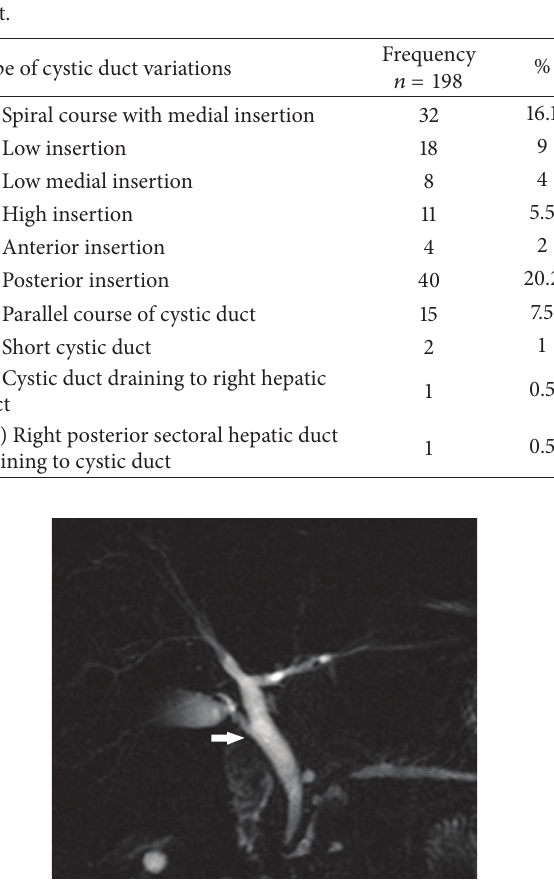
Figure 1: Coronal oblique 3D MR cholangiopancreatography shows normal insertion of cystic duct at middle 3rd of common hepatic duct from lateral aspect